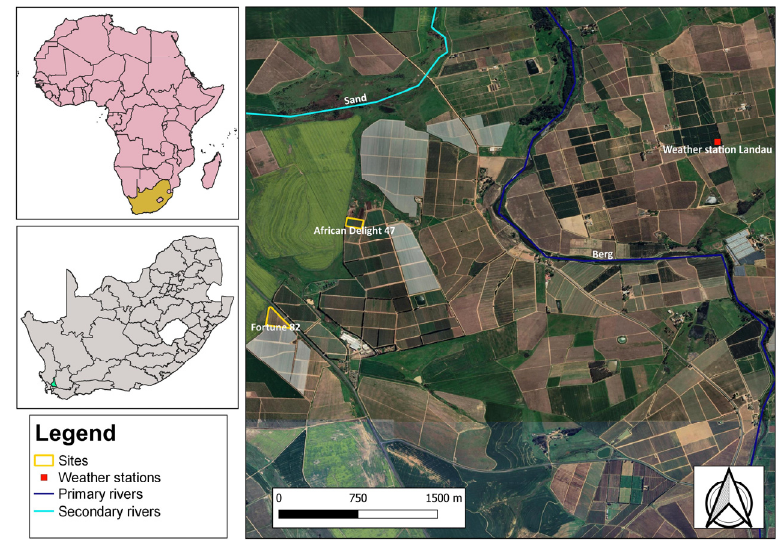
Figure 1. Location of the experimental orchards and associated weather stations on Google Earth maps: Smuts Bros farm near Robertson ( top ) and Sandrivier farm near Wellington ( bottom ).